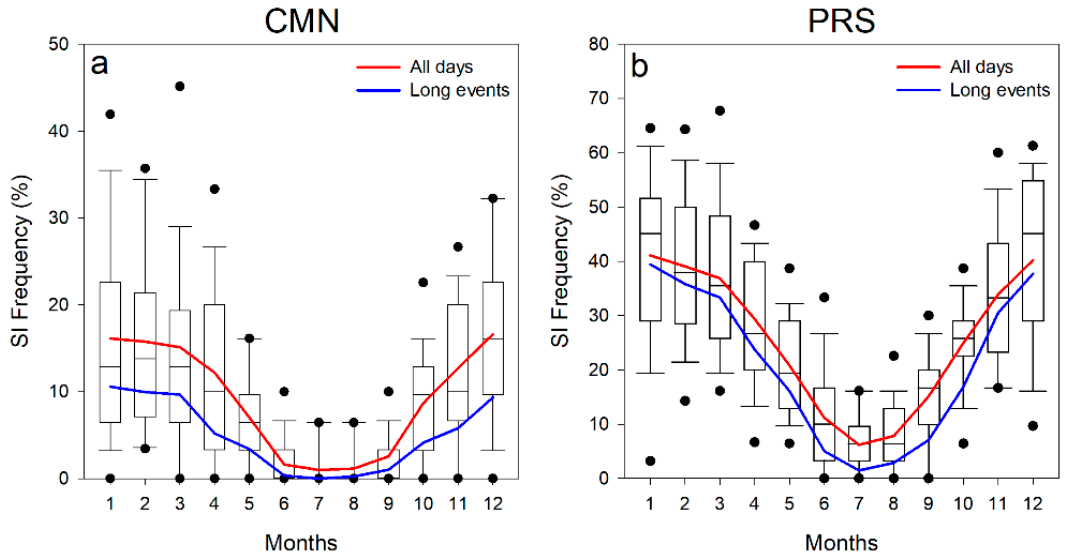
Figure 5. Time series of annual SI frequency for the four measurement sites, together with the trend estimates (solid lines) and the 95% confidence intervals for the trends (dashed lines). The SI frequency values calculated by using all SI events are shown in red, while blue depicts the SI frequency values considering only “long” SI events (i.e., longer than three days). At the top-left of each plot, the two overall trends are shown, together with the 95% confidence intervals in the slope. The significance of the trend is expressed as follows: p < 0.05 = * and p < 0.1 = +.